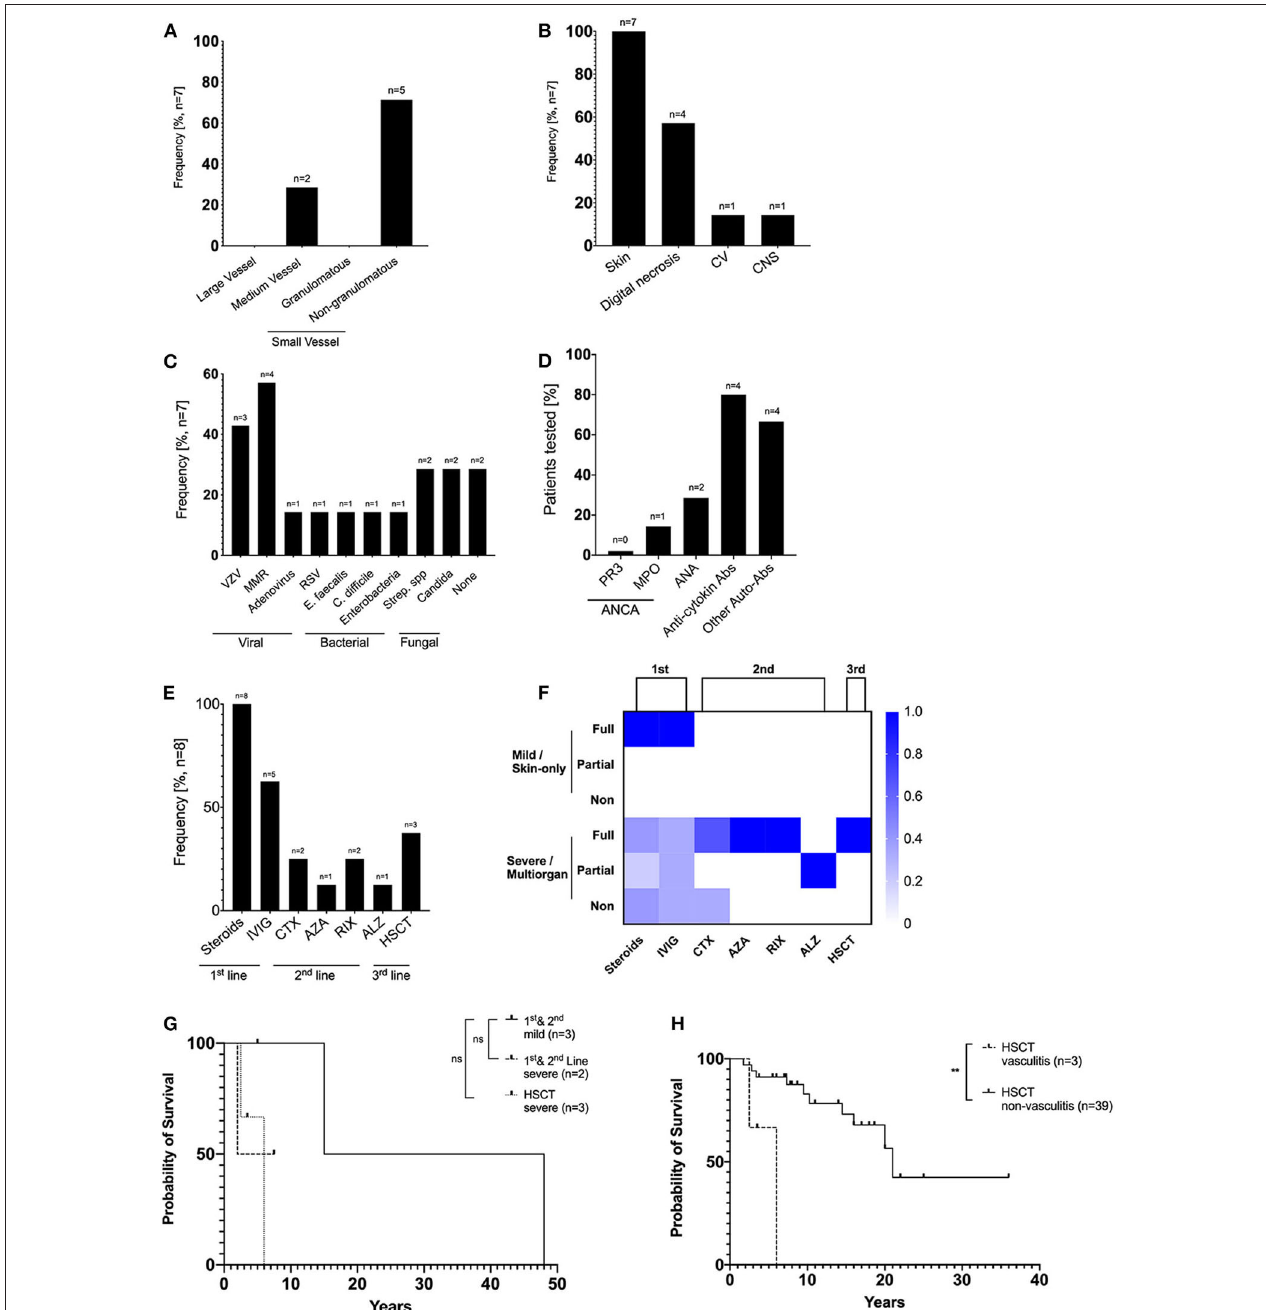
FIGURE 2 | Detailed description of vasculitis and treatment outcome in patients with RAG deficiency. (A) Relative frequency of large, medium and small vasculitis among RAG patients (B) Relative frequency of target organs affected by vasculitis (C) Relative frequency of potential infectious trigger preceding episodes of vasculitis. (D) Prevalence of autoantibodies among RAG patients. Anti-cytokine included antibodies against IFN α , ω , and IL-12. Other autoantibodies included anti-erythrocyte, platelet, dsDNA, TPO, TG, ALPA antibodies. (E) Treatment strategies used in patients with vasculitis due to RAG deficiency (F) Treatment response scored for first line (steroids ± IVIG), second line (biologicals or immunosuppressives), or third line (Haematopoietic stem cell transplantation) was scored using the following criteria: “non,” no clinical response or side effects were limiting; “partial,” clinical improvement but therapeutic escalation was required; or “full,” clinical improvement with no escalation. (G) Kaplan-Meier curves comparing survival of RAG-deficient patients with severe, systemic multiorgan vasculitis that underwent HSCT ( n = 3, dashed line), patients with severe, systemic multiorgan vasculitis that received first/second line therapy ( n = 2, dotted line) and patients with mild, skin limited vasculitis ( n = 3, straight line). (H) Kaplan-Meier curves comparing survival of RAG-deficient patients with vasculitis ( n = 3, dashed line) and RAG-deficient patients without vasculitis ( n = 39, straight line) that underwent HSCT (ns statistically not significant, ** p ≤ 0.01).